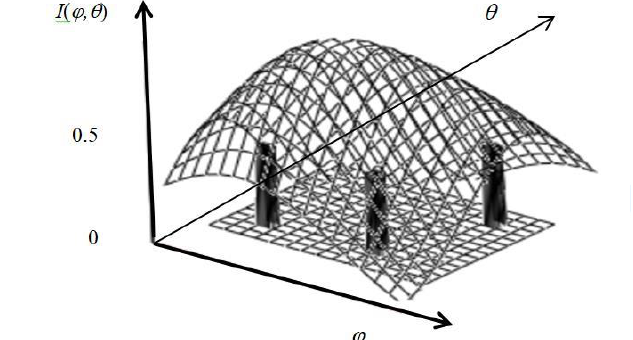
Fig. 2. Reconstructed image of a two-dimensional